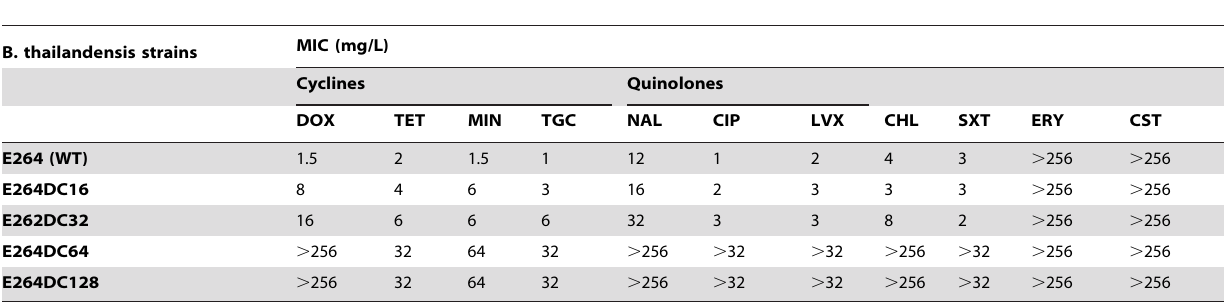
Table 1. Susceptibility of B. thailandensis strains to cyclines, and antibiotics from other classes.